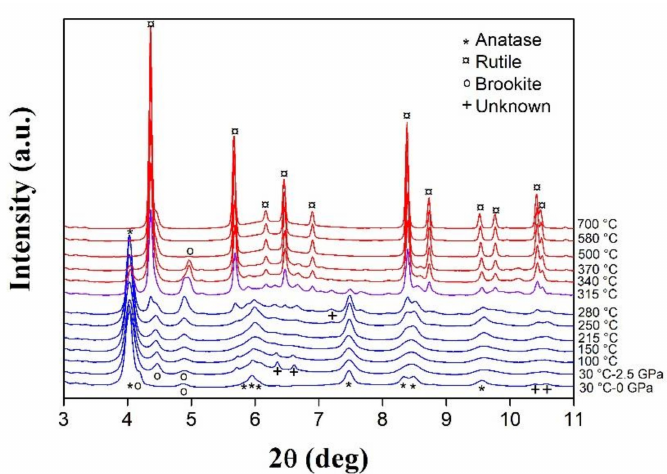
Figure 18. In situ X-ray diffractograms collected on heating during SPS treatment of a 15 nm TiO 2 nanopowder at 3.5 GPa (ID27 beamline, ESRF, λ = 0.2468